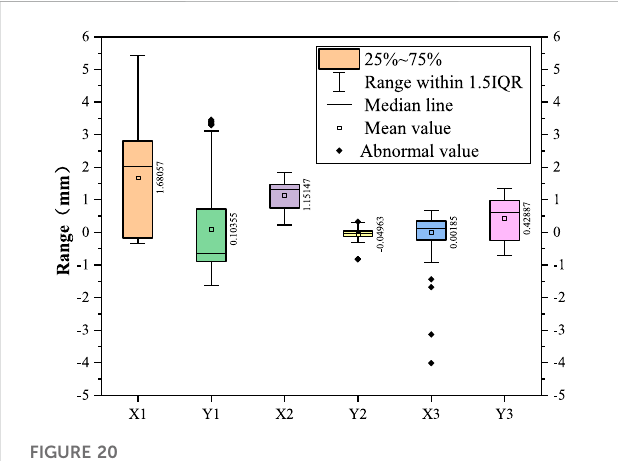
FIGURE 20 Analysis of box line analysis of joint difference deformation monitoring at different measuring points from 20 May 2022 to 31 May 2022.